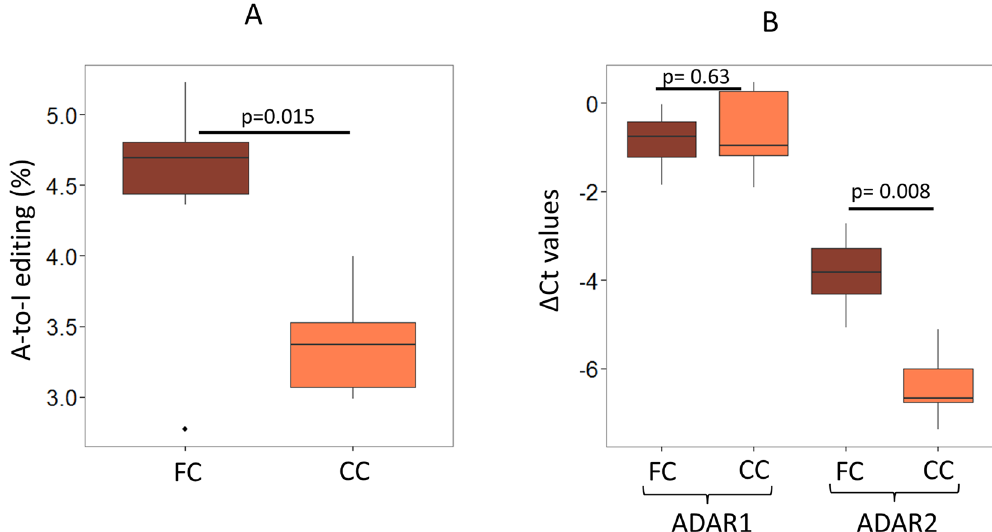
Figure 3. Neuron rich frontal cortex (FC) showed higher A-to-I editing in mature miRNAs than the corresponding corpus callosum (CC) of the same individuals. ( A ) FC showed higher A-to-I editing than CC of the same individuals (two-tailed t-test; p = 0.015). ( B ) Real-time PCR was done and delta Ct was plotted, ADAR2 (and not ADAR1, two-tailed t-test; p = 0.63) showed significant upregulation in FC compared to